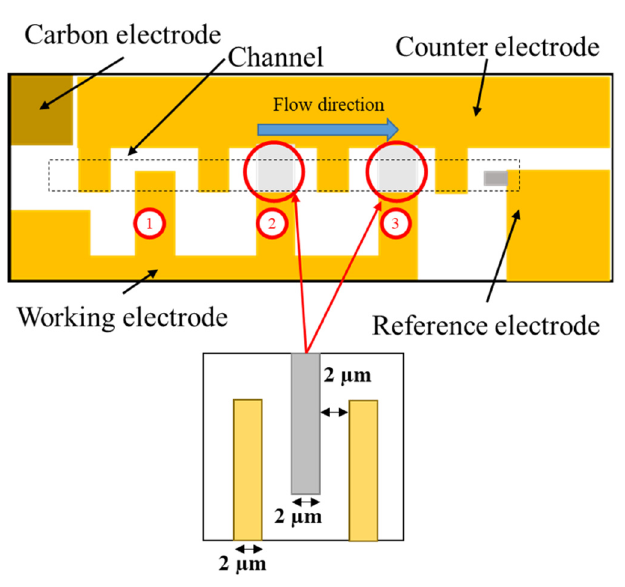
Figure 2. Illustration of an electrode with an incorporated microfluidic system. The figure below shows the detailed structure of the comb electrodes of the second and third electrodes.